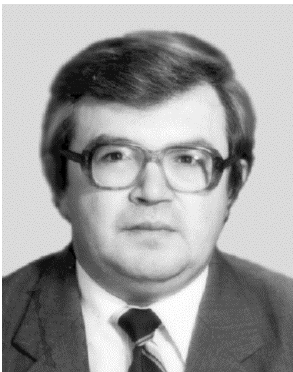
Fig. 3. V. V. Pustovoytenko